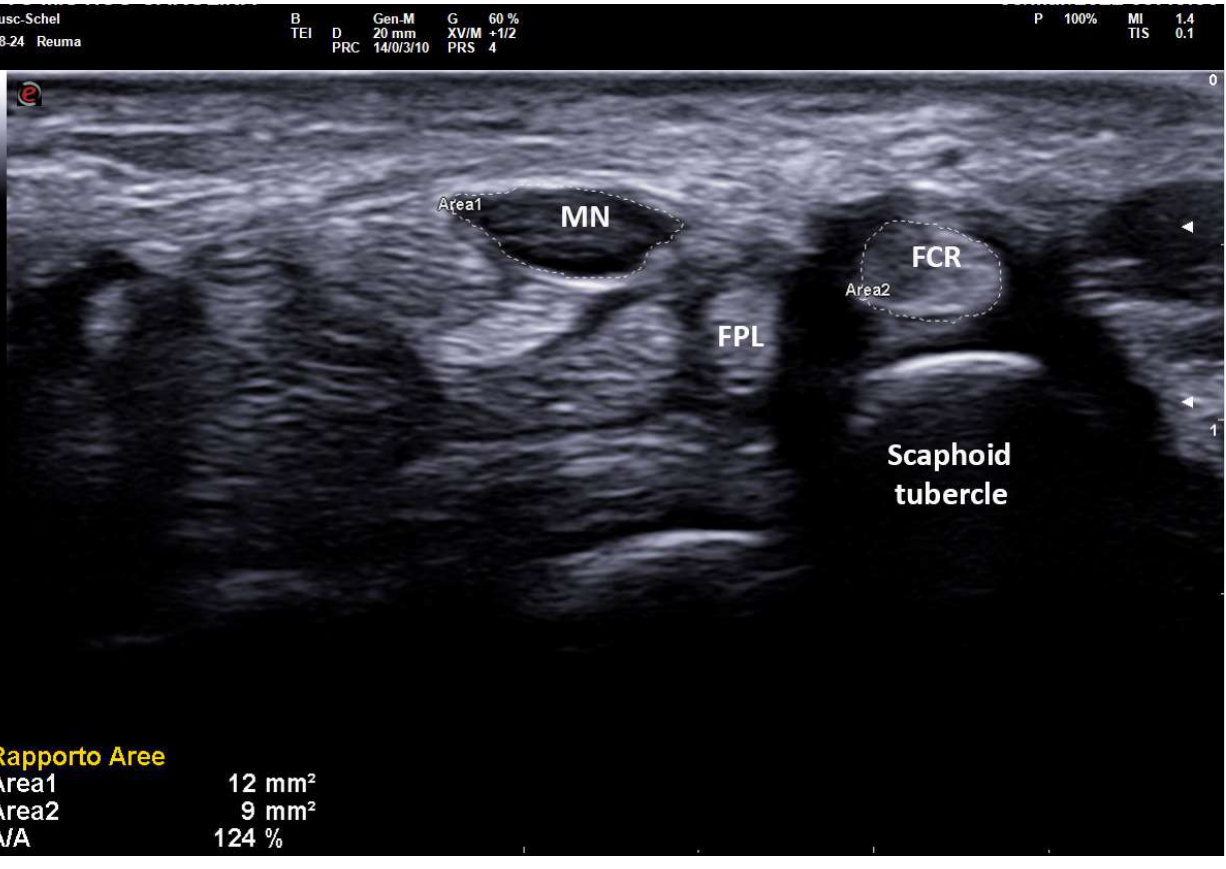
Figure 5. Transverse scan over right carpal tunnel in a small female patient (150 cm × 50 kg, 13.7 cm of wrist circumference) affected with medium-grade CTS (Padua Scale 3, SCV 37.1 m/sec, DML 4.8 ms). Linear 8–24 MHz probe. Both areas of median nerve (MN) and flexor carpi radialis (FCR) were manually traced. A MN-CSA of 12 mm 2 is not always considered pathologic (cut-off for MN neuropathy until 14–15 mm 2 in some studies on CTS) and the severity is often underestimated because of the anthropometric characteristics of the patient. The NTR shows values unequivocally pathologic (124%), as MN-CSA is compared with an anatomic structure (FCR-CSA) that maintains small dimensions in CTS, following the anthropometric characteristics of the patient.